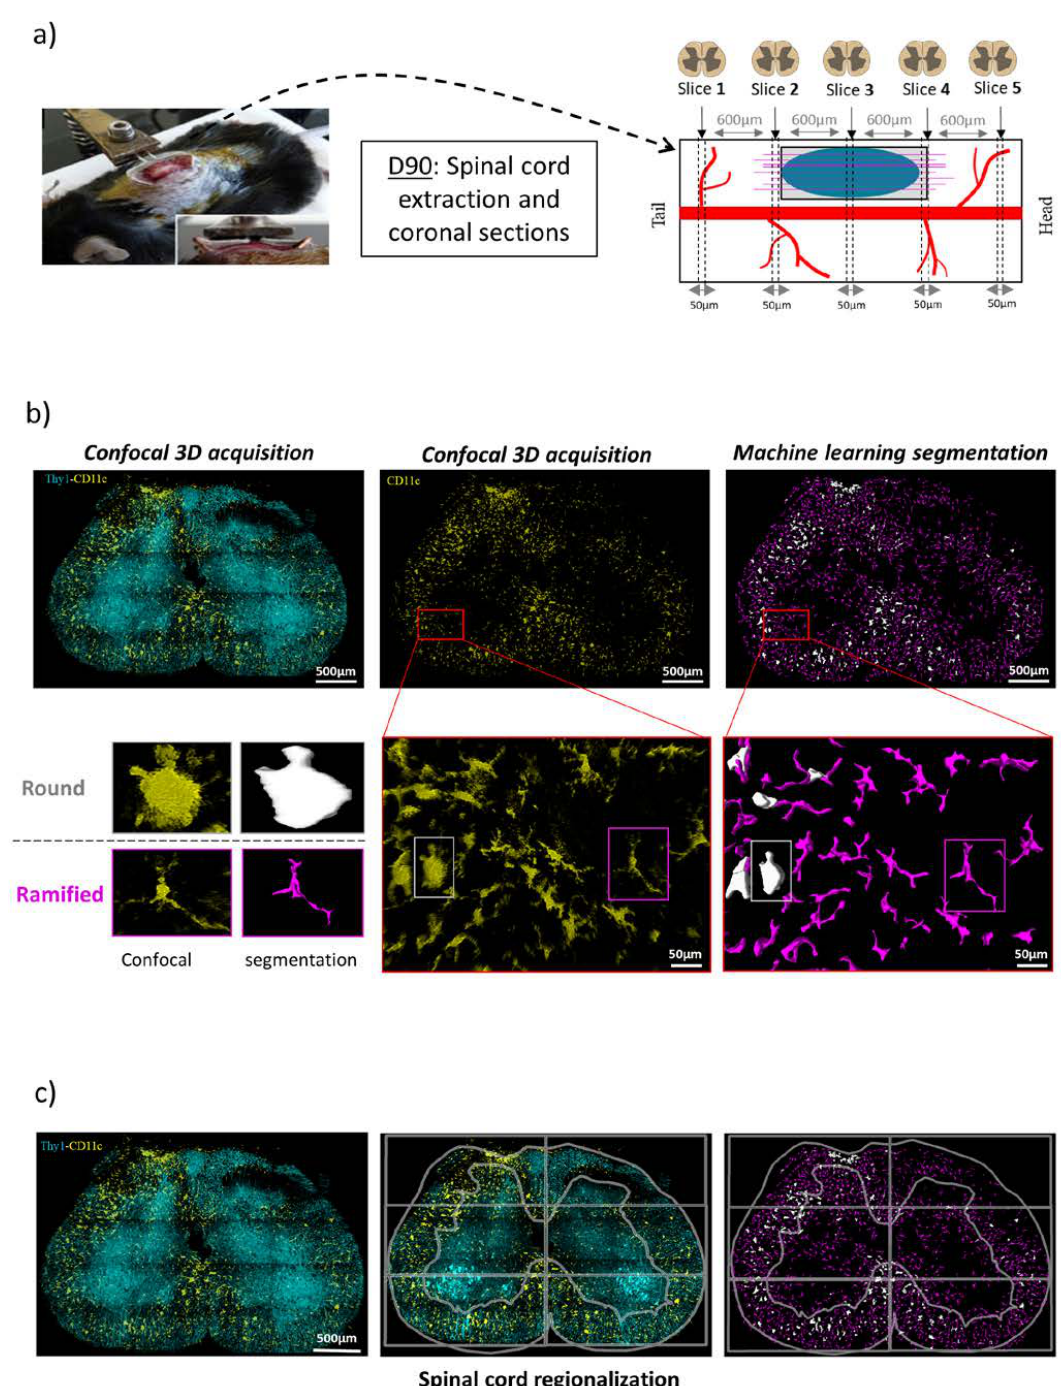
Figure 4. Automated machine learning segmentation protocol reveals two morphologically distinct populations of CD11 + cells in spinal cord sections on D90. ( a ) On D90 the chronic inflammatory status was evaluated from coronal 50 µ m thick spinal sections taken every 600 µ m on both side of the lesion epicenter. Scheme represents the spinal cord with its blood vessels (red), lesion area (grey), MFs (pink) embedded in a fibrin bundle (blue). ( b ) Representative confocal images showing Thy1-CFP neurons and CD11c + cells (left), or CD11c + cells only (middle); two classes (white and purple) segmentation (right) of the raw image (middle) obtained after 3D machine learning pipeline on Arivis software. Morphology of round miroglia (white) and ramified microglia (purple) is illustrated in zoomed insets from the outlined regions of interest (red). ( c ) Round (white) and ramified (purple) CD11c+ cells